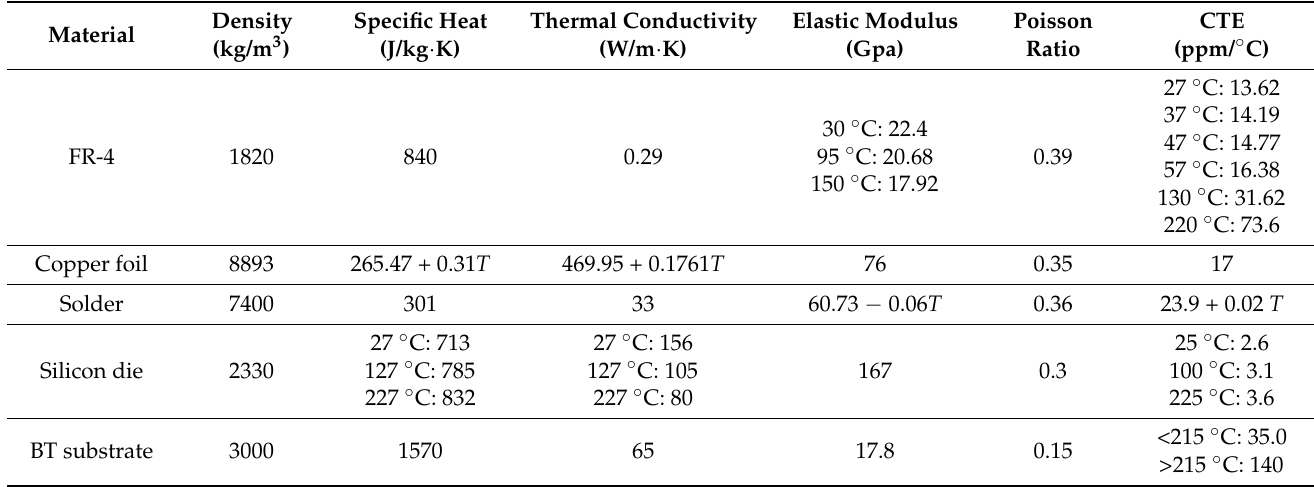
Table 2. Material properties of each component.